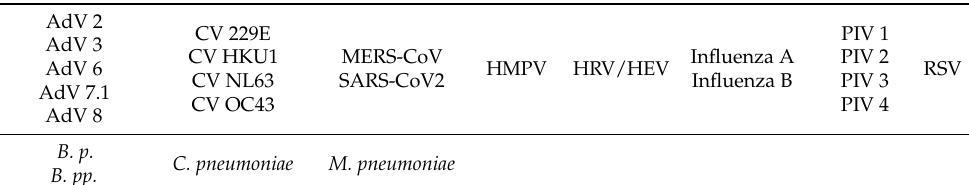
Table 1. Respiratory virus and bacteria panel for studying the pathogenome of nasopharyngeal swab specimens of the study